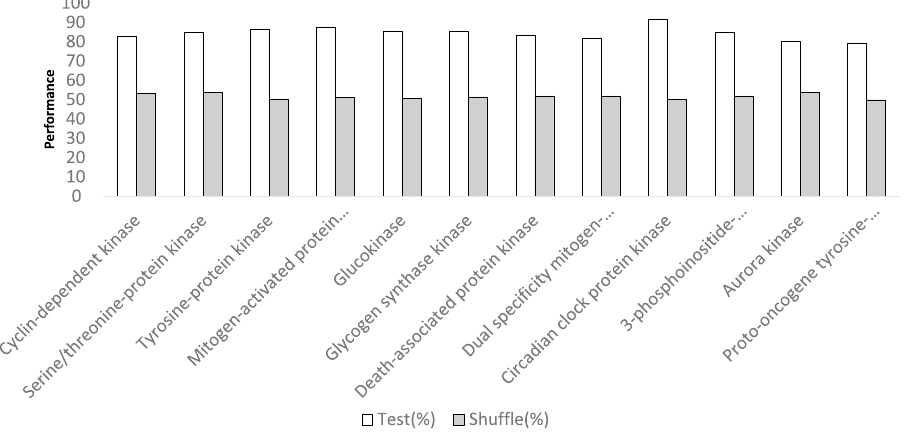
Figure 2. Comparison of the performance of the shuffled and testing